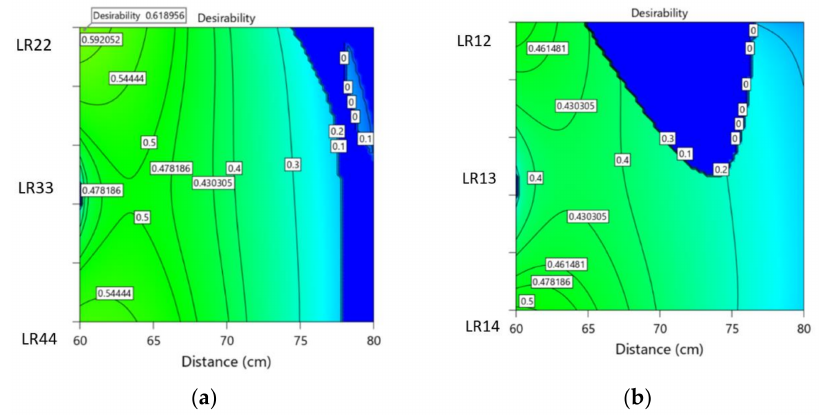
Figure 11. Desirability 2D contour plot without ( a ) and with ( b ) White LED